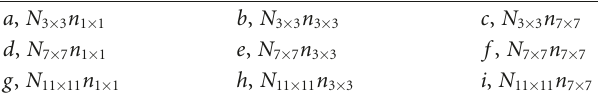
Table 5: Combinations of neighborhoods N and n with di ff erent sizes.